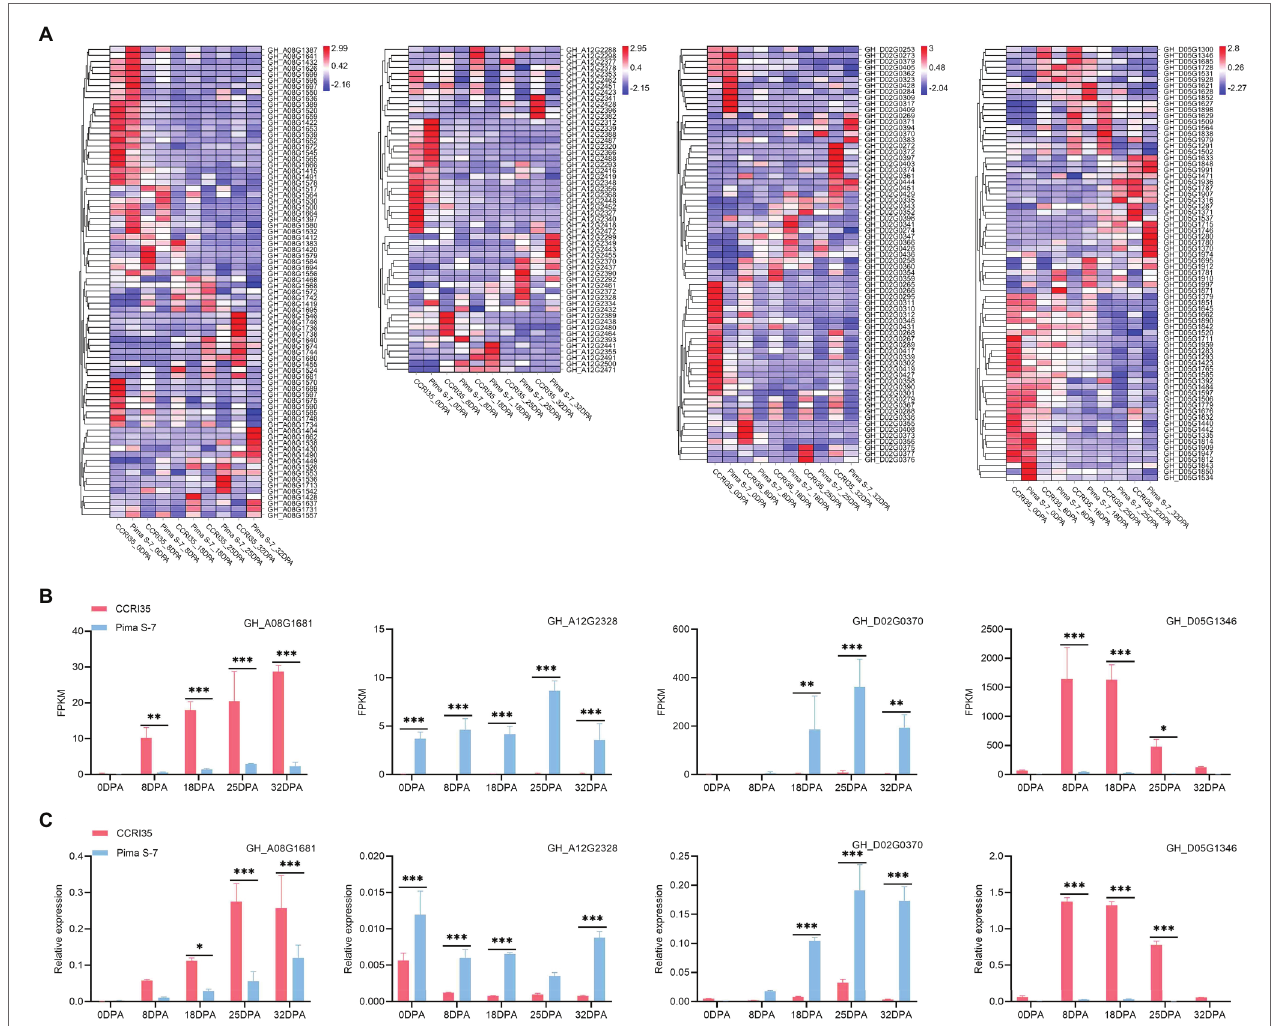
FIGURE 3 | Expression profiles of fiber-related genes at different development stages. 0 DPA: mixture of ovule and fiber; 8, 18, 25, and 32 DPA: fiber. (A) Heat map showing expression profiles of candidate genes for stable QTL ( qFL-Chr08-2, qFL-Chr12-1, qFL-Chr14-1, and qFM-Chr19-1 ) at different fiber development